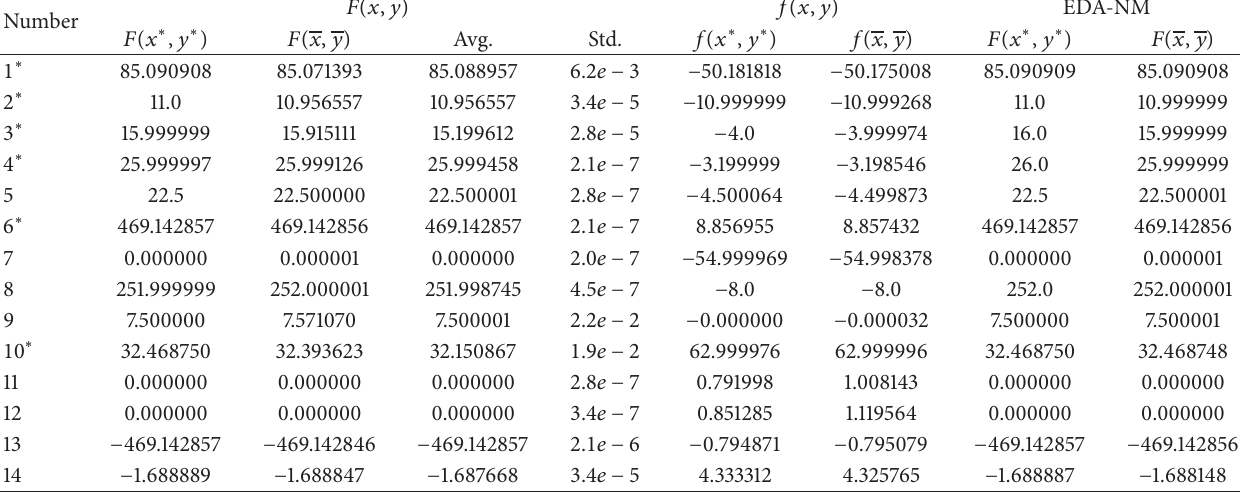
Table 2: The results found by EDA with